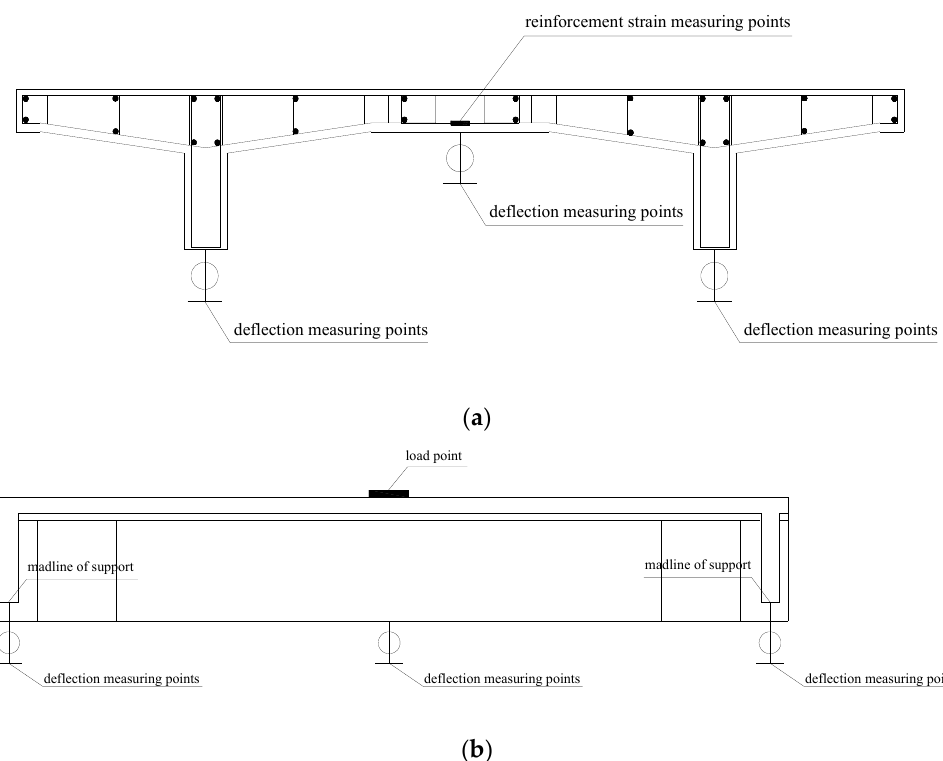
Figure 7. The arrangement of the deflection measuring and reinforcement strain measuring points. ( a ) Front view. ( b ) Side view.